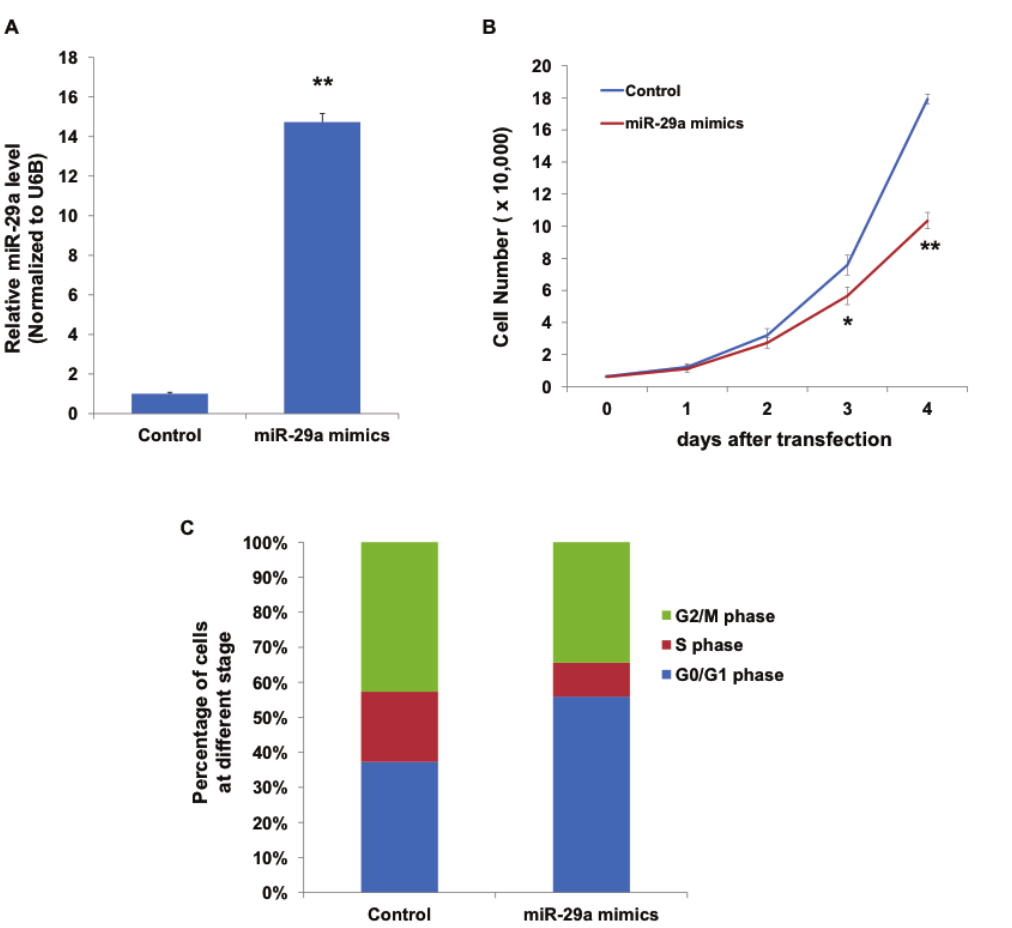
Figure 2: Effects of miR-29a on MDA-MB-453 cell viability. (A) MDA-MB-453 cells were transfected with miR-29a mimics or controls and subjected to qRT-PCR analysis. (B) Effect of miR-29a on MDA-MB-453 cell proliferation was measured by cell counting assay. *: P<0.05. **: P<0.01. (C) Effect of miR-29a on MDA-MB-453 cell cycle was measured by flow cytometry. G0/G1 arrest was increased by miR-29a overex- pression. The results represent three independent experiments.